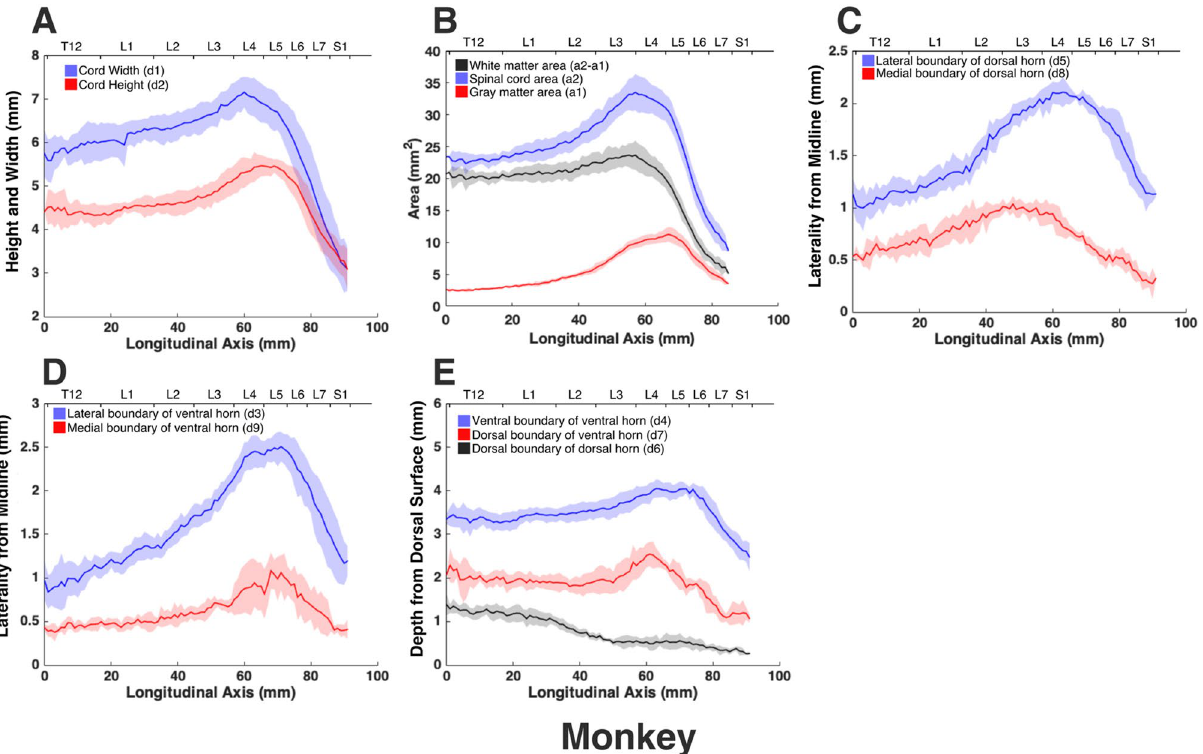
Figure 11. Measurements of cross-sectional dimensions of the spinal cord and locations of the ventral and dorsal horns of monkey spinal cord. Presented data are based on n = 6 specimens. Solid lines represent the mean and the shaded regions represent the mean ± standard deviation. ( A ) Spinal cord width and height (d1 and d2, respectively in Fig. 7, left) across the lumbosacral cord. ( B ) Cross-sectional areas of the spinal cord and gray matter (a1, a2 in Fig. 7, right) across the lumbosacral cord. ( C ) Mediolateral distances from midline to the dorsal horn boundaries (d5, d8 in Fig. 7, middle). ( D ) Mediolateral distances from midline to the ventral horn boundaries (d3, d9 in Fig. 7, middle). ( E ) Depth from the dorsal surface of the spinal cord of the ventral and dorsal horn boundaries (d4, d7, d6, in Fig. 7,